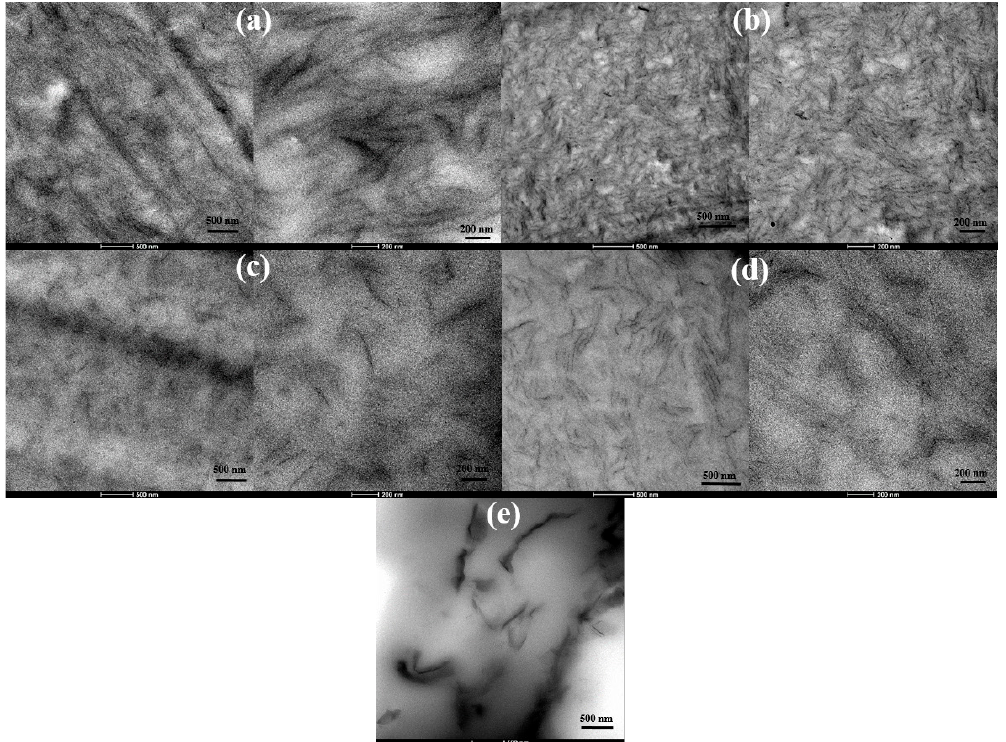
Figure 5. TEM images of: unplasticized ( a ) PVA/GS1, ( b ) PVA/GS2; plasticized ( c ) PVA/GS1, ( d ) PVA/GS2; and ( e ) PVA/GS1 ex situ, at different magnifications.